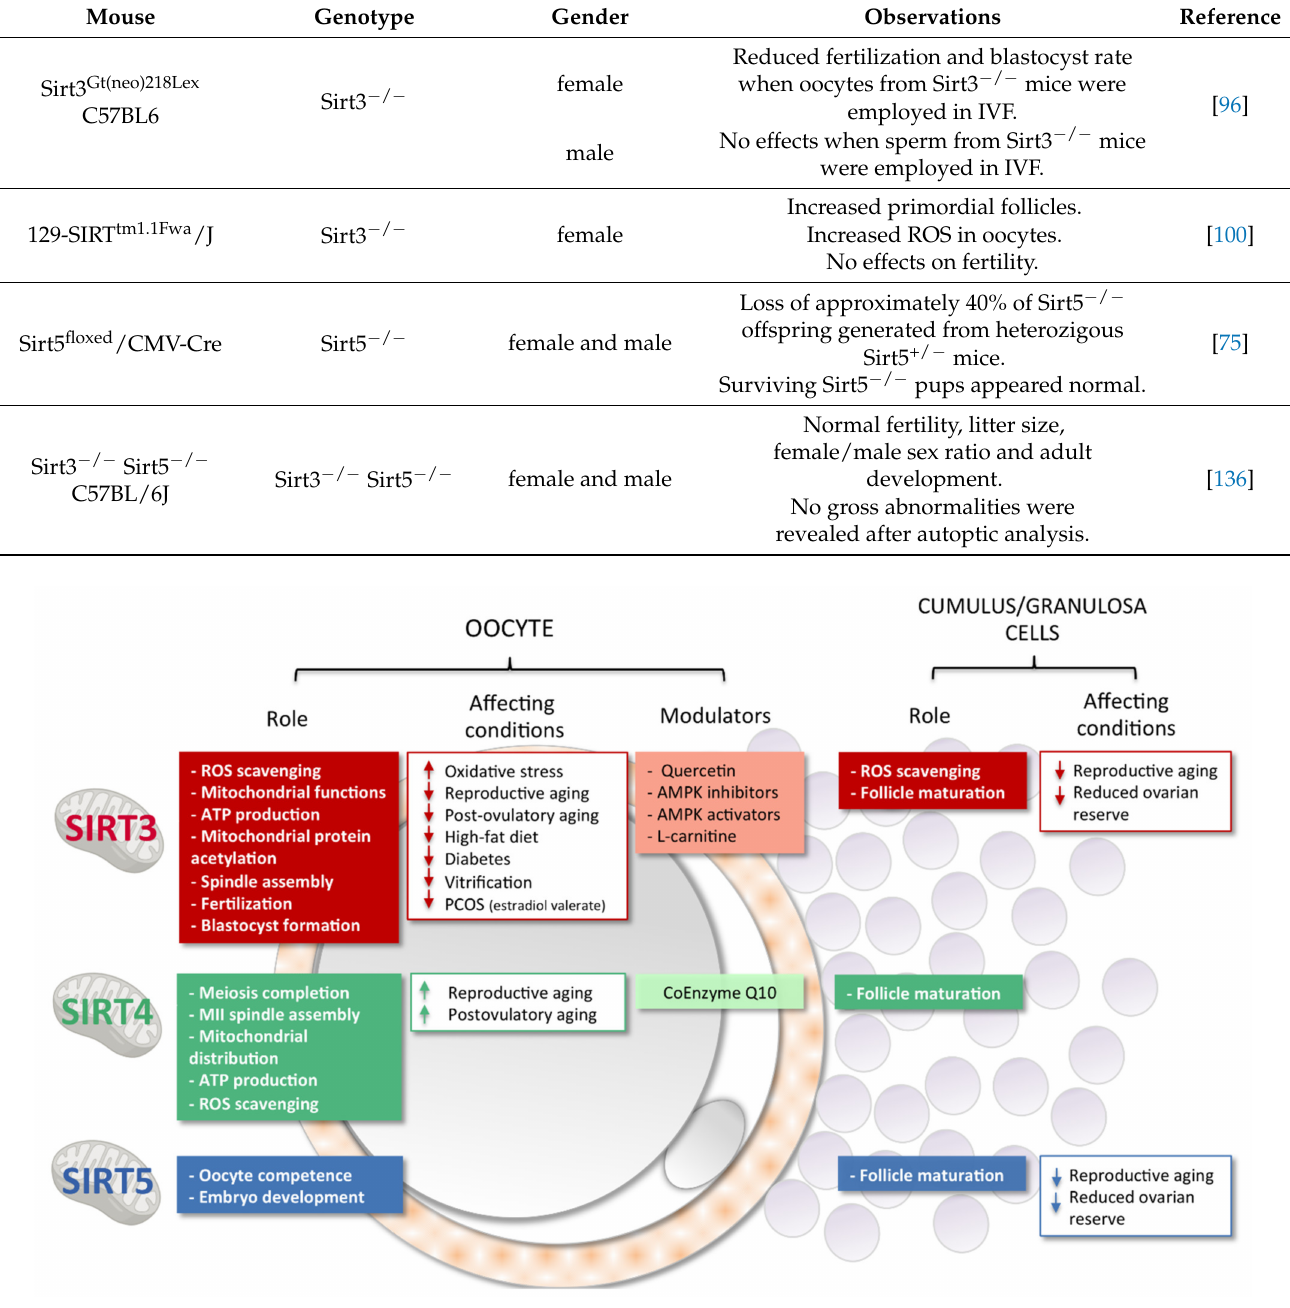
Figure 4. Role of mtSIRTs in oocytes and somatic companions, cumulus cells (CCs) and granulosa cells (GCs) are summarized. Conditions affecting the activity of mtSIRTs and possible beneficial intervention based on media supplementation are